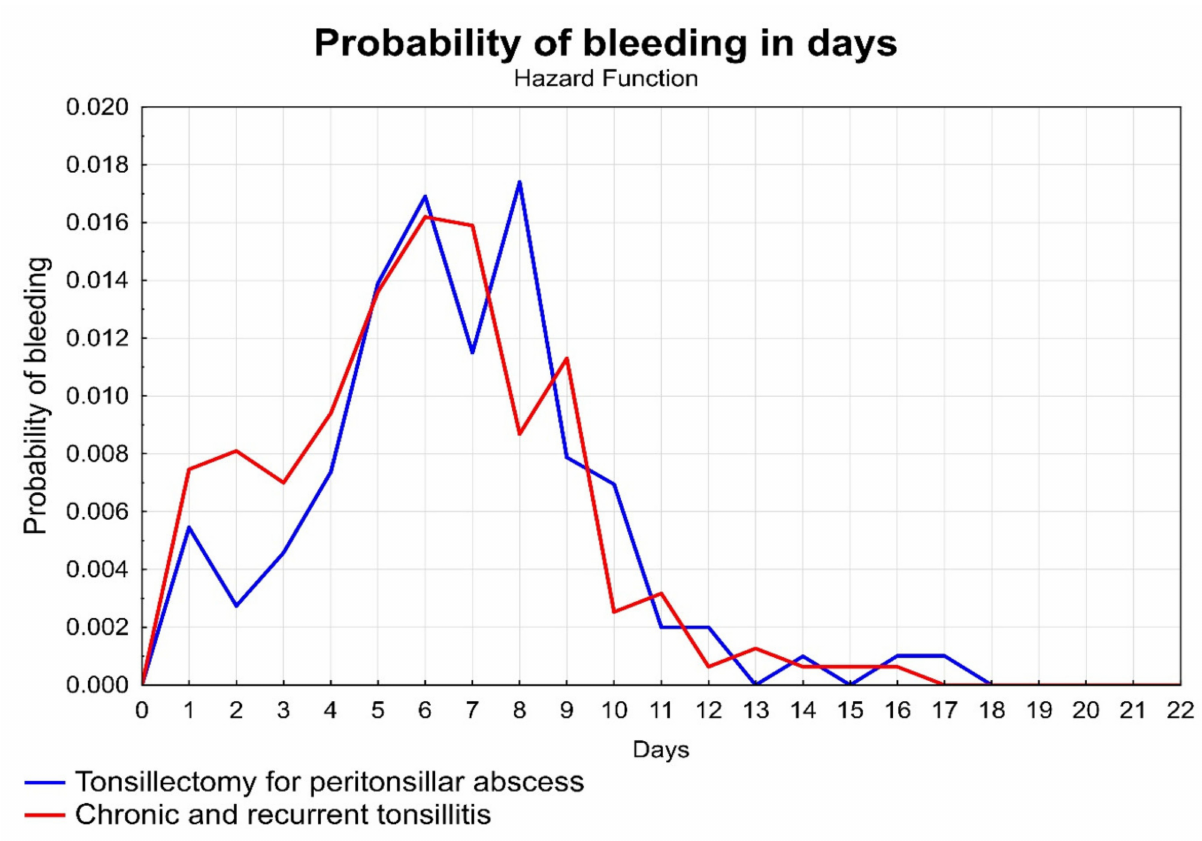
Figure 4. Probability of bleeding on individual